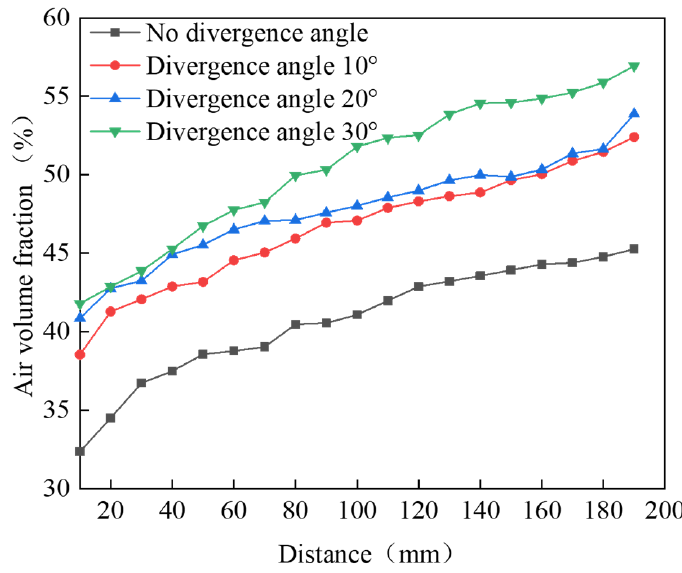
Figure 14. Effect of divergence angle on air volume fraction.